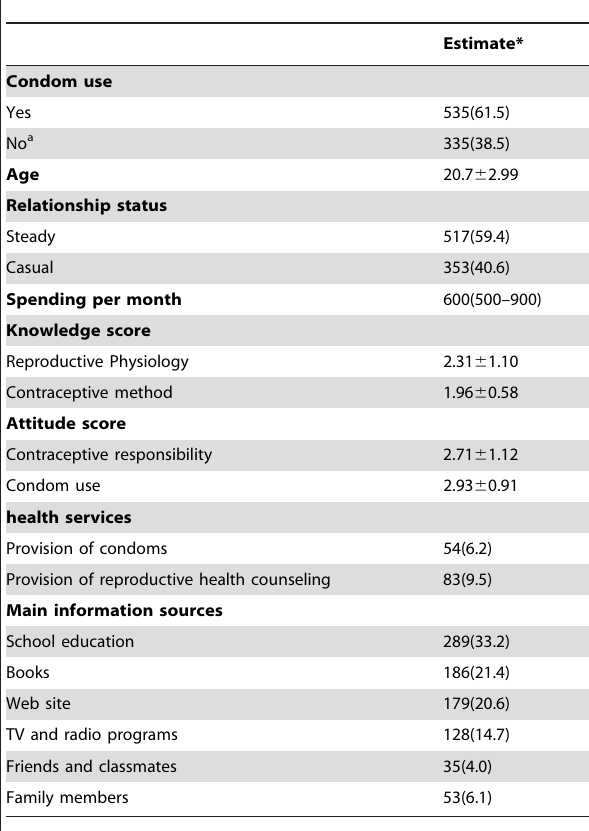
Table 3. Distribution of dependent variables and individual reproductive health knowledge, attitudes, information sources, and health services among sexually active male